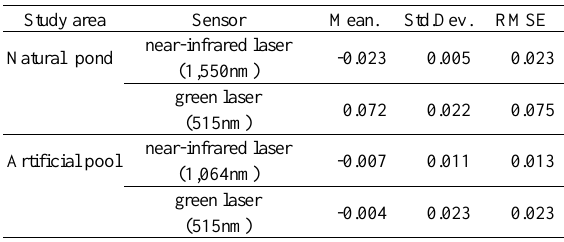
Table 5. Elevation comparison of GCPs and LiDAR points